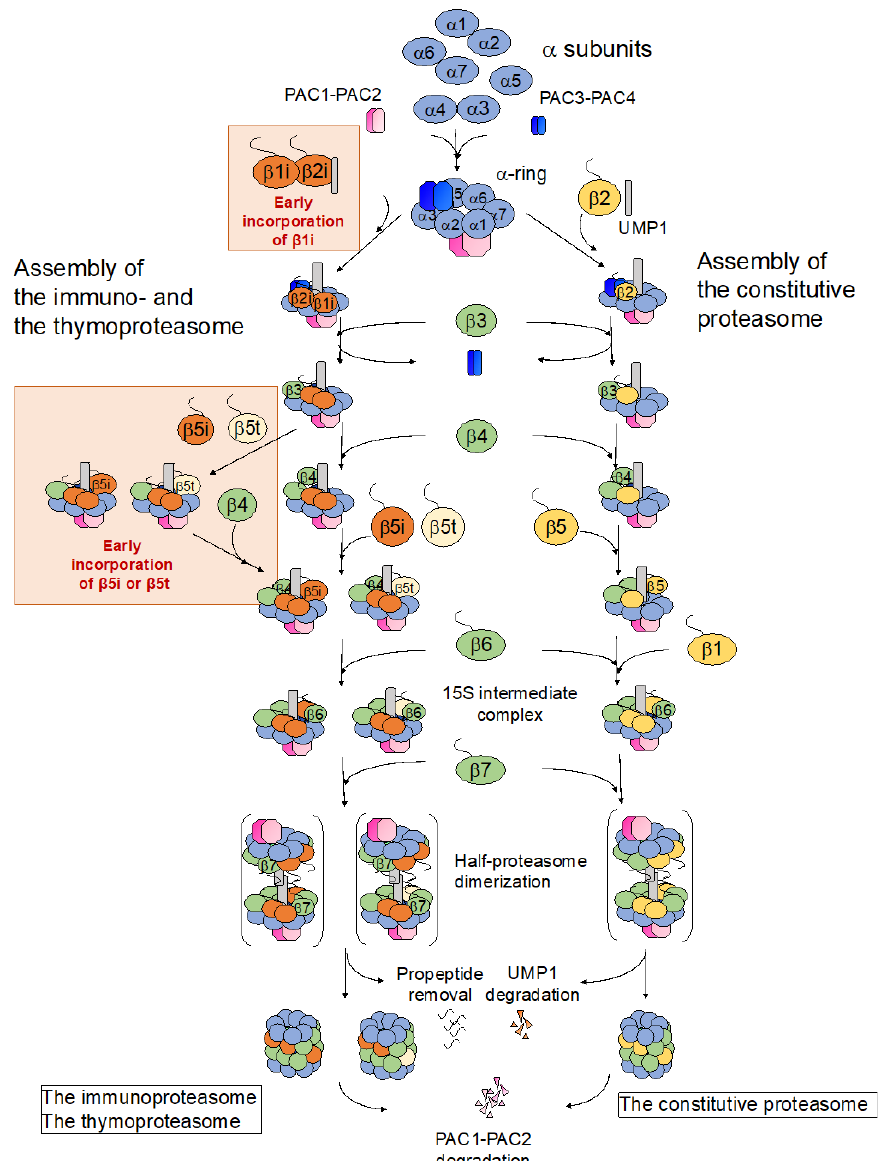
Figure 2. Assembly pathways of the constitutive, the immuno-, and the thymoproteasomes. There are two differences between the assembly pathway of the constitutive proteasome and that of the immuno- and the thymoproteasomes. The first difference is that β 1i is incorporated earlier than constitutive β 1. The second is that constitutive β 5 is incorporated after β 4, whereas β 5i and β 5t can be incorporated on the α -ring independent of β 4, and either β 4 or β 5i and β 5t can be incorporated into the β -ring immediately after the incorporation of β